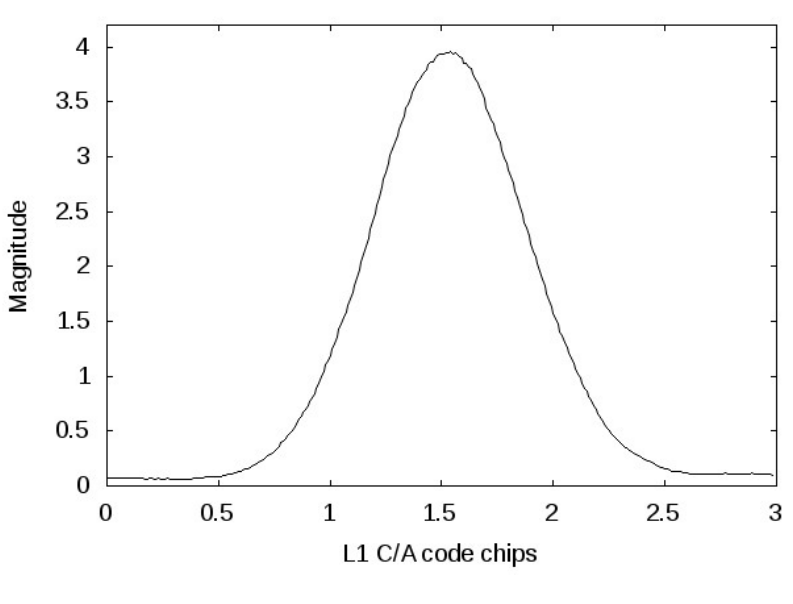
Figure 5. An example power delay for February 4th 2005 signal. The x-axis is in GPS L1 C/A code chips and the y-axis is the total accumulated signal power after 100 ms of non-coherent averaging. For an example of how chip delays map to the surface, see Figure 1.